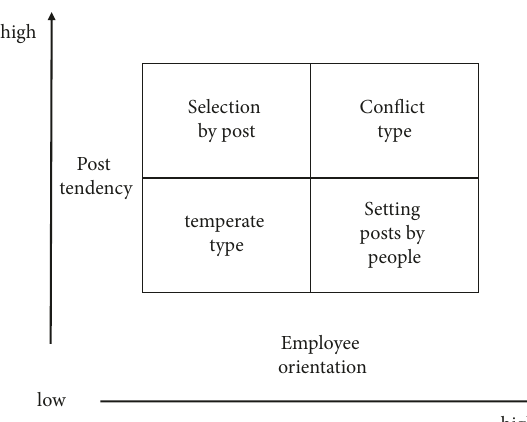
Figure 1: Power trade-off matrix model for energy post matching.